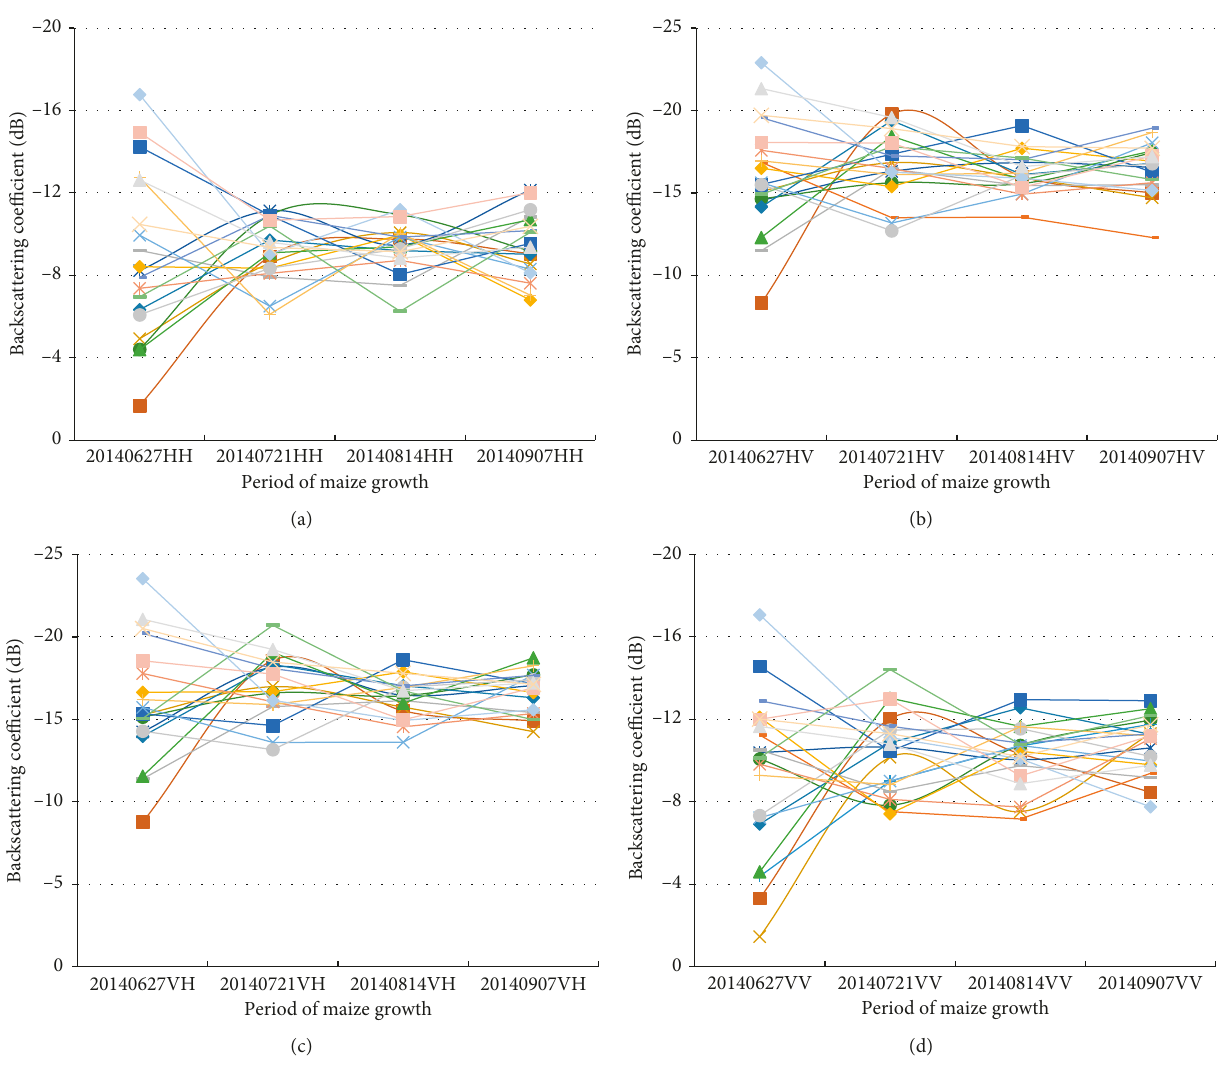
Figure 6: Backscattering coefficients used to evaluate roads bordered by trees.